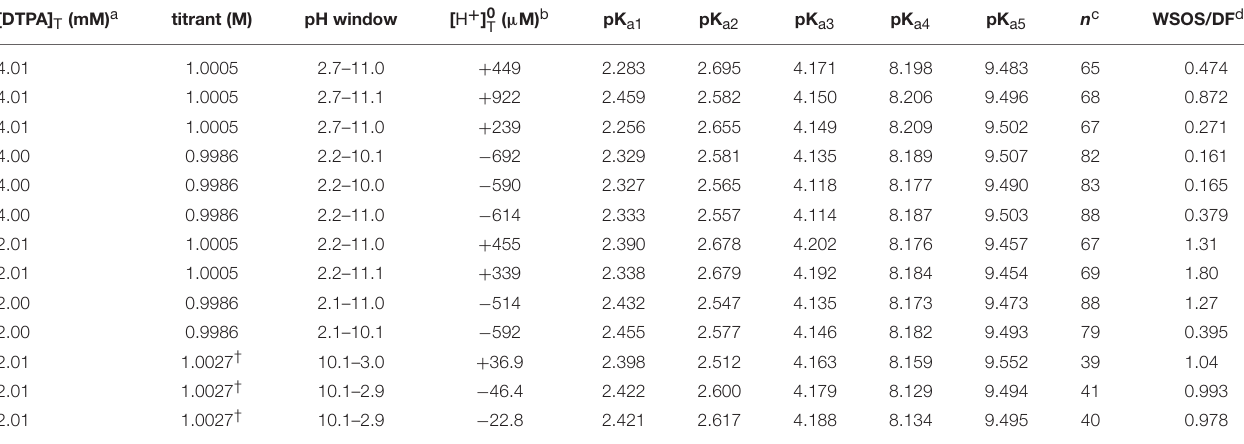
TABLE 2 | Thirteen titrations of diethylenetriaminepentaacetic acid (DTPA) in 50mL of 0.7M NaClO 4